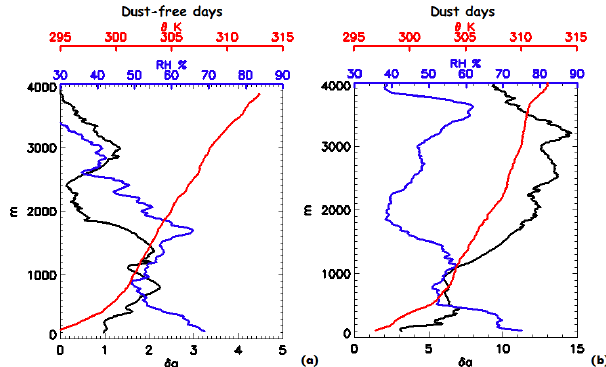
Figure 11. Figure reports the mean vertical profiles of δ a , RH and θ for dust-free (a) and dust days (b) at 05:00UTC. Please note the different horizontal axis for δ a